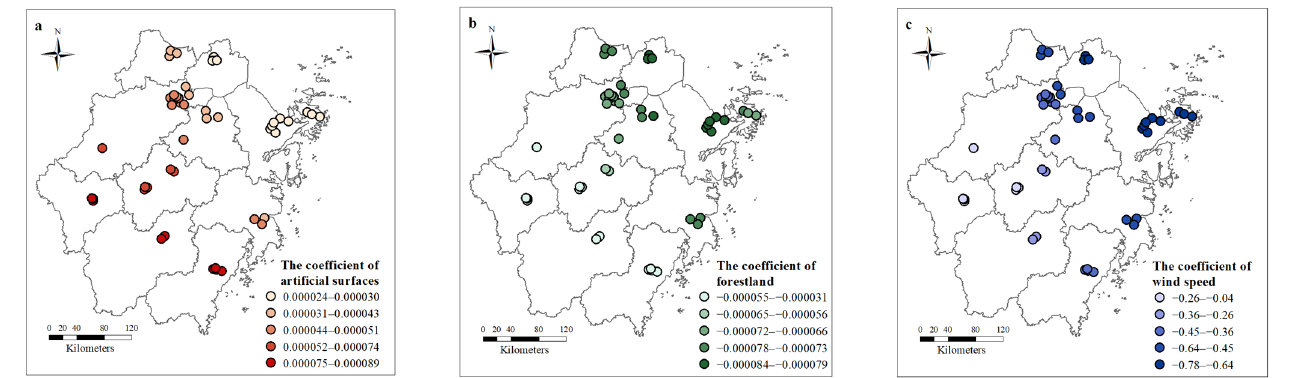
Figure 4. The coefficient of artificial surfaces ( a ), forestland ( b ), and wind speed ( c ) in the geographically weighted regression (GWR).